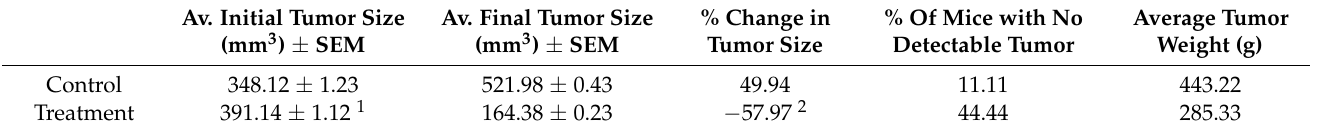
Table 8. A. citrodora effect on tumor size, weight, cure, and deaths percentages, in EMT-6/P cell